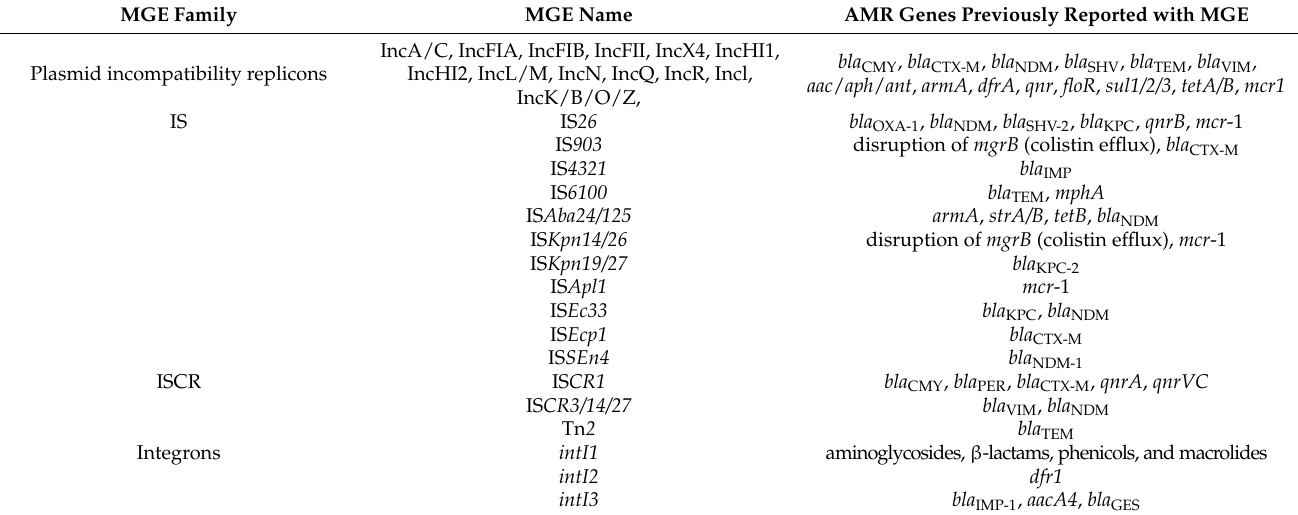
Table 2. Mobile genetic elements (MGEs) selected for the AMR–Array